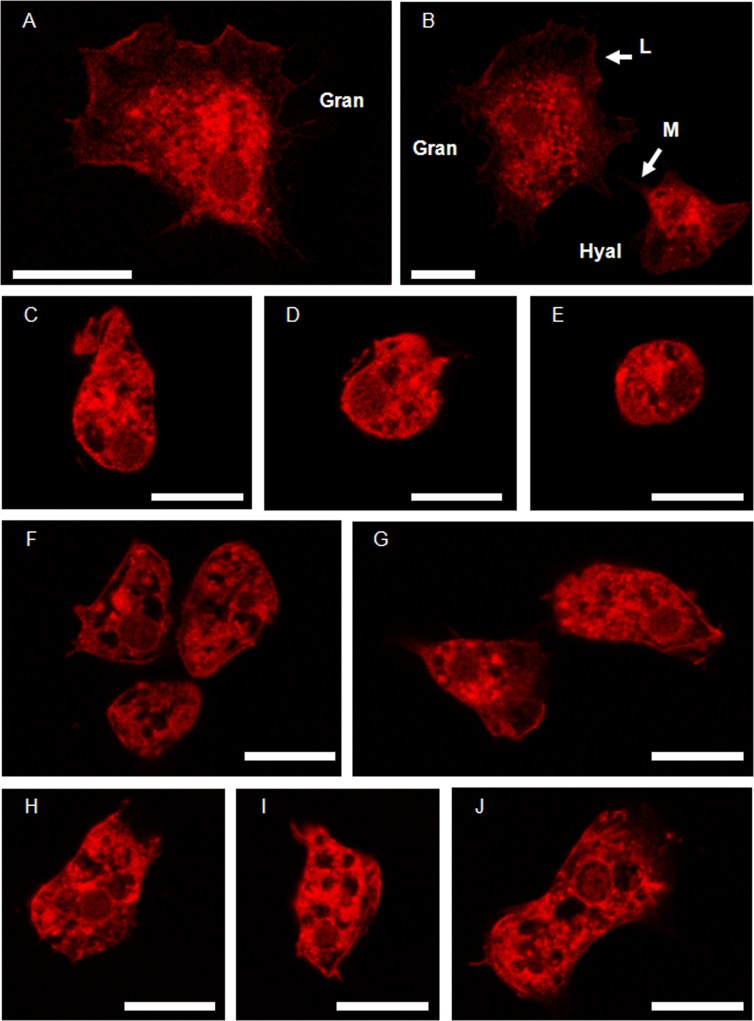
Effects of ionic Ag, bulk Ag and Ag NPs on the actin cytoskeleton of hemocytes.Actin cytoskeleton (labelled with TRITC-conjugated phalloidin) of untreated mussel hemocytes (A and B) and hemocytes treated with ionic Ag (C-E), bulk Ag (F and G) and Ag20-Mal NPs (H-J). Hyal, hyalinocyte; Gran, granulocyte; L, lamellipodia; M, microspikes. Scale bars = 20 μm.